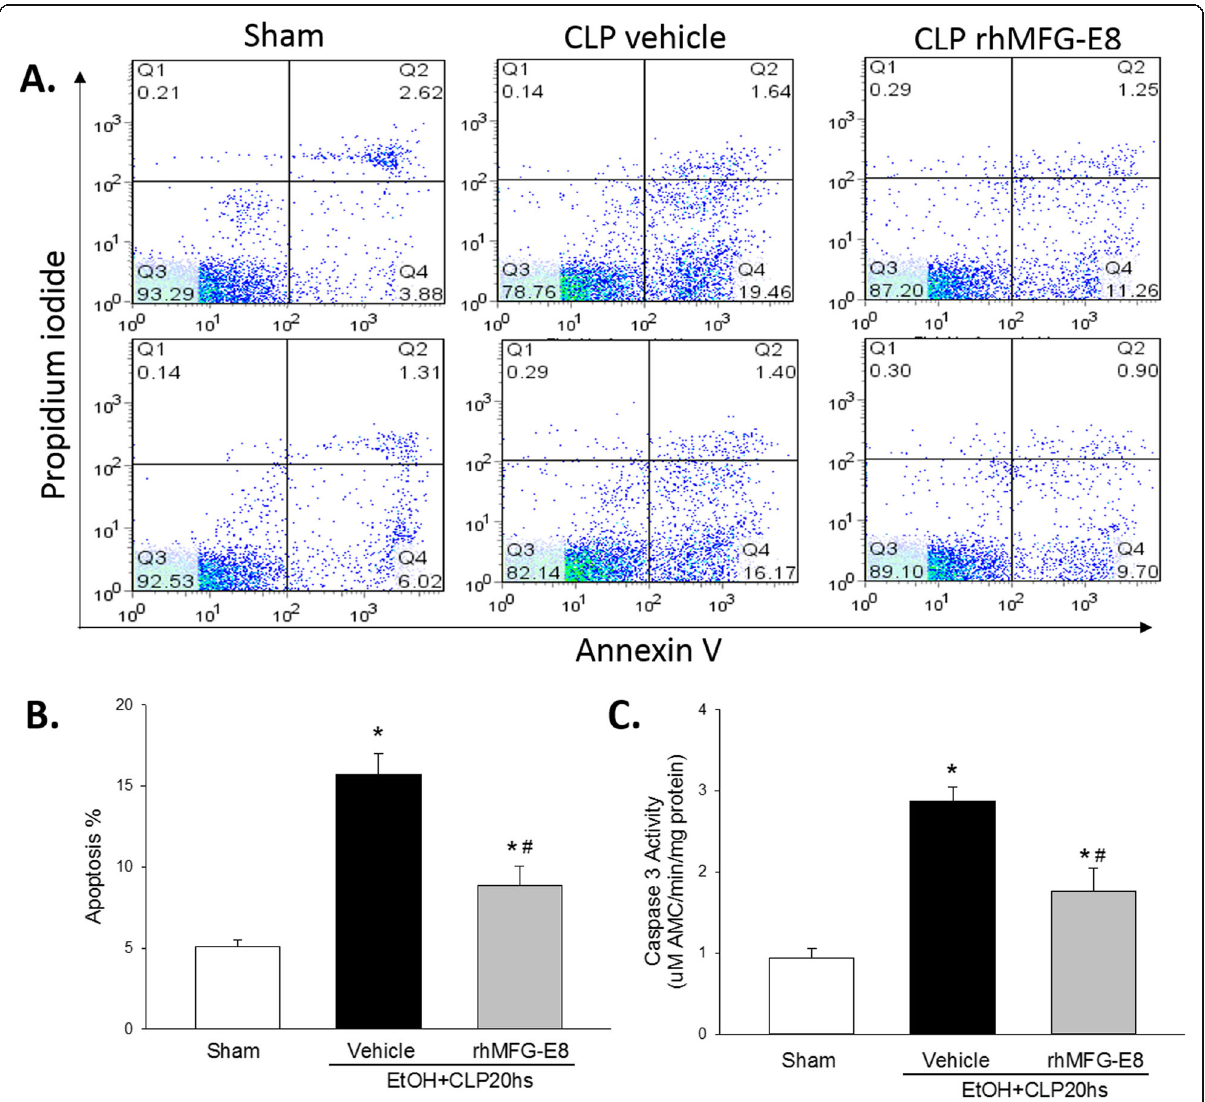
Fig. 5 rhMFG-E8 is associated with reduced apoptosis in CLP after acute alcohol exposure. Early apoptotic cells in the thymus, ( a ) assessed by flow cytometry (lower right quadrant, Q4; representative image) ( b ) and quantified, and apoptosis in the ( c ) spleen, assessed using caspase 3 activity, were increased rats subjected to CLP and treated with vehicle (human albumin) compared with sham surgery, and lower in rats subjected to CLP and treated with rhMFG-E8. Prior to CLP, all rats were exposed to acute alcohol intoxication; means + SE; n = 10 – 14 for sham and n = 9 for other experimental groups; ANOVA plus Student-Newman-Keuls method, * P < 0.05 vs. Sham, # P < 0.05 vs.